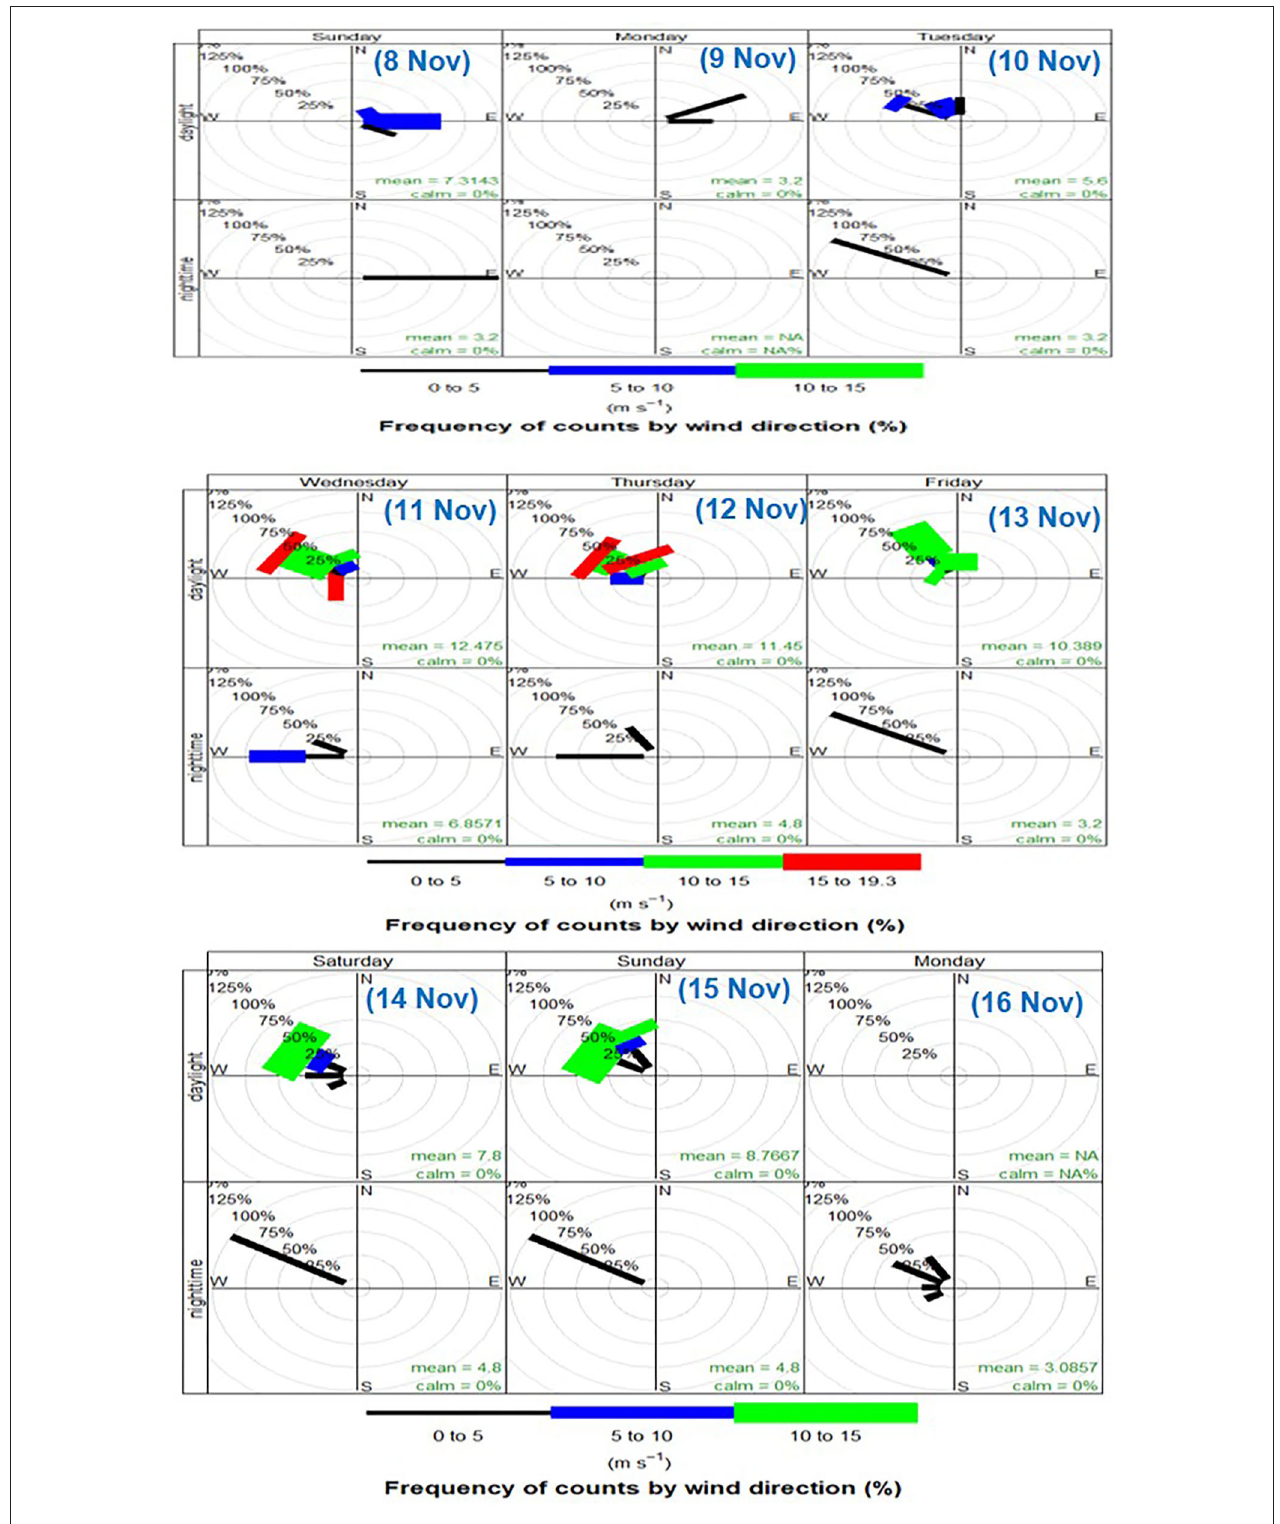
FIGURE 2 | Wind-rose diagram showing day-night variability pattern of wind speed (shown by different colors) and direction frequencies during the entire campaign.